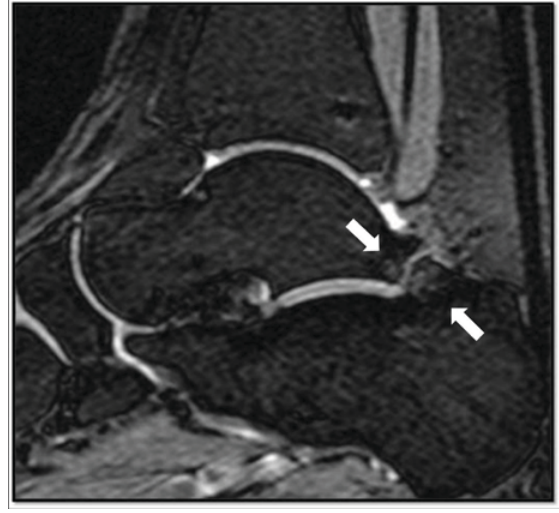
Figure 3. Sagittal gradient echo (MEDIC) MR image, showing the impinging bony structures as well as the bone marrow edema